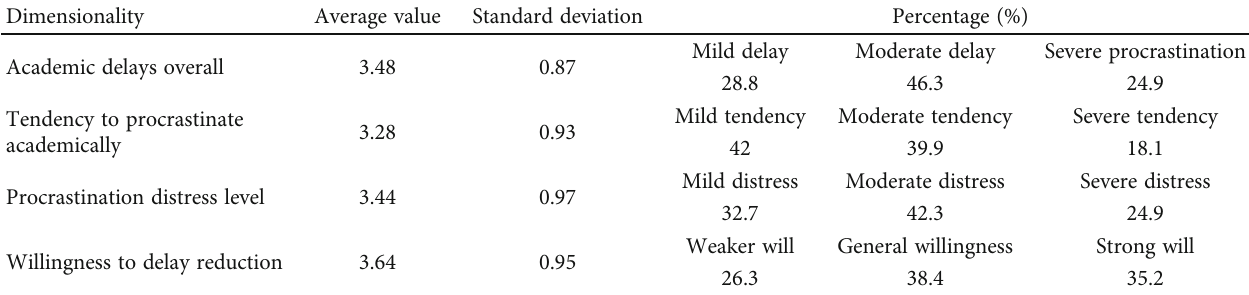
Table 2: Results of the survey on the status of